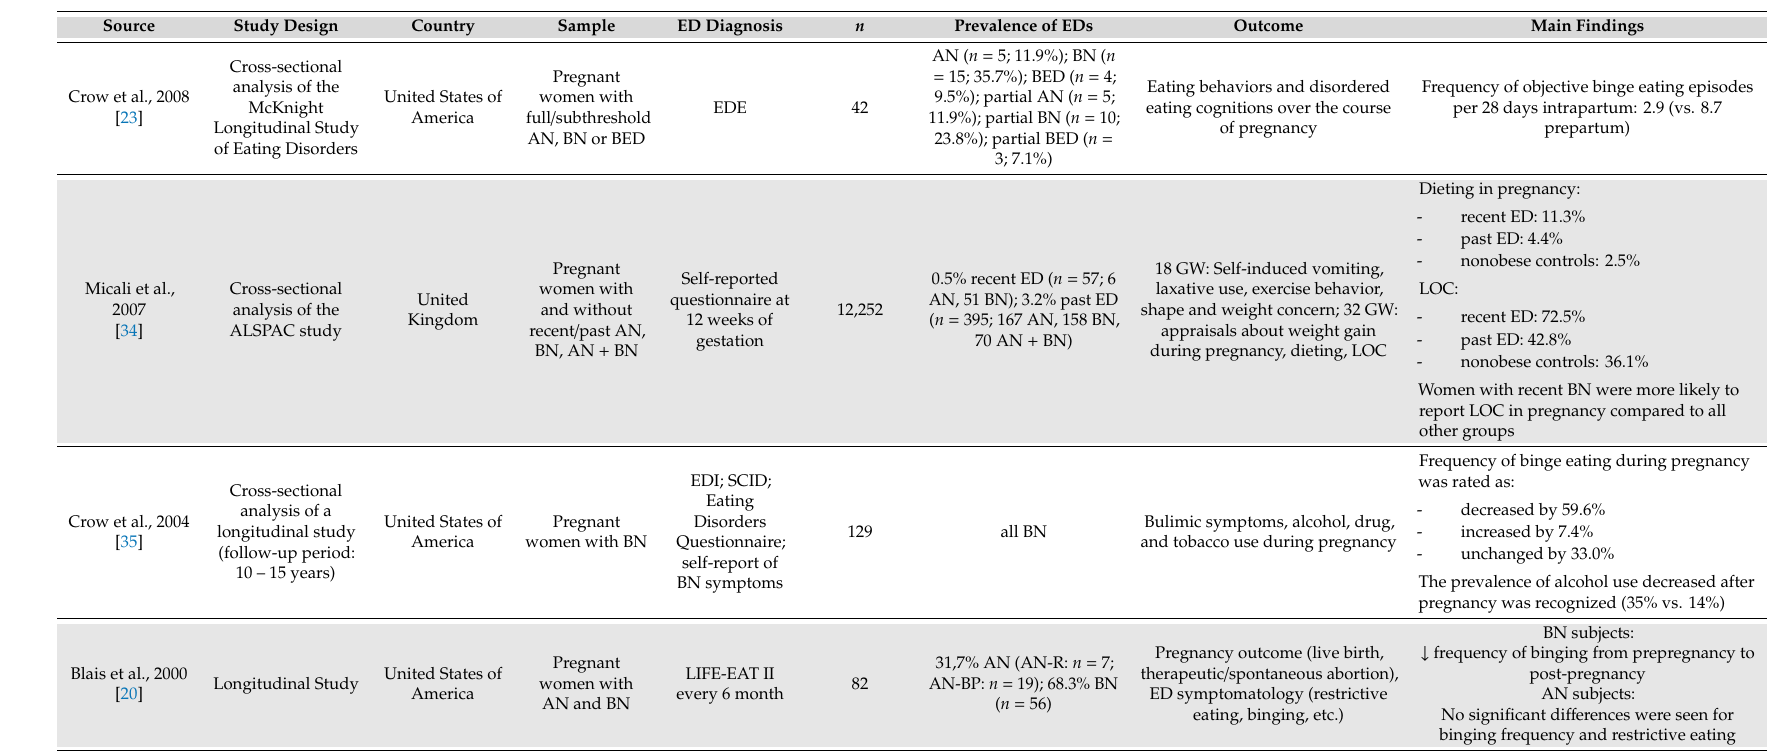
Table 3. Studies investigating eating behavior in pregnant women with eating